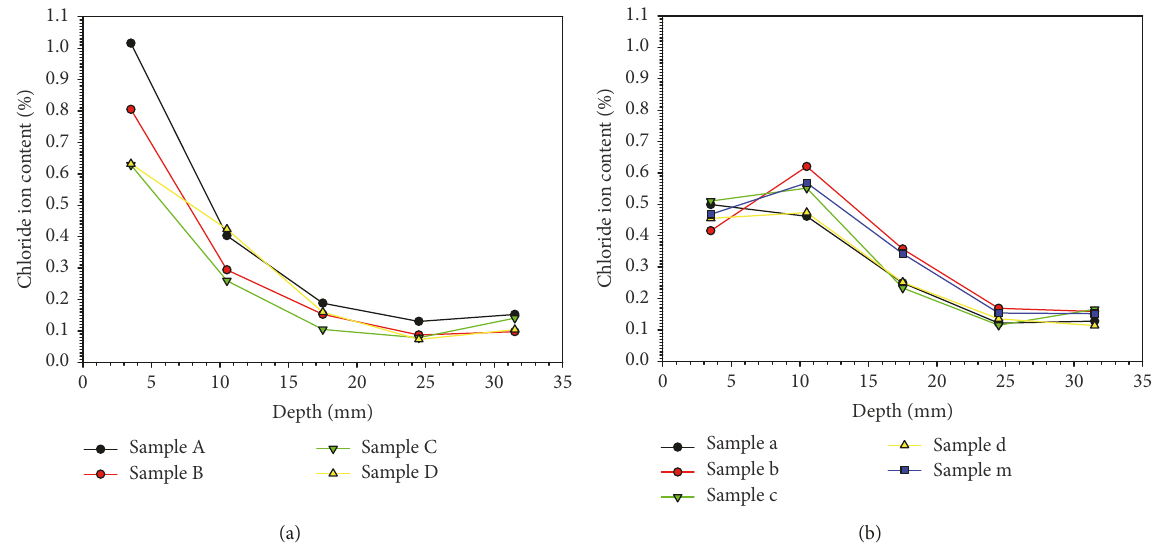
time, 𝐶(𝑥, 𝑡 = 0) = 𝐶 0 ; (3) the content of chloride ion in concrete is 𝐶 0 at infinity, 𝐶(𝑥 = ∞, 𝑡) = 𝐶 0 , a special solution can be obtained from